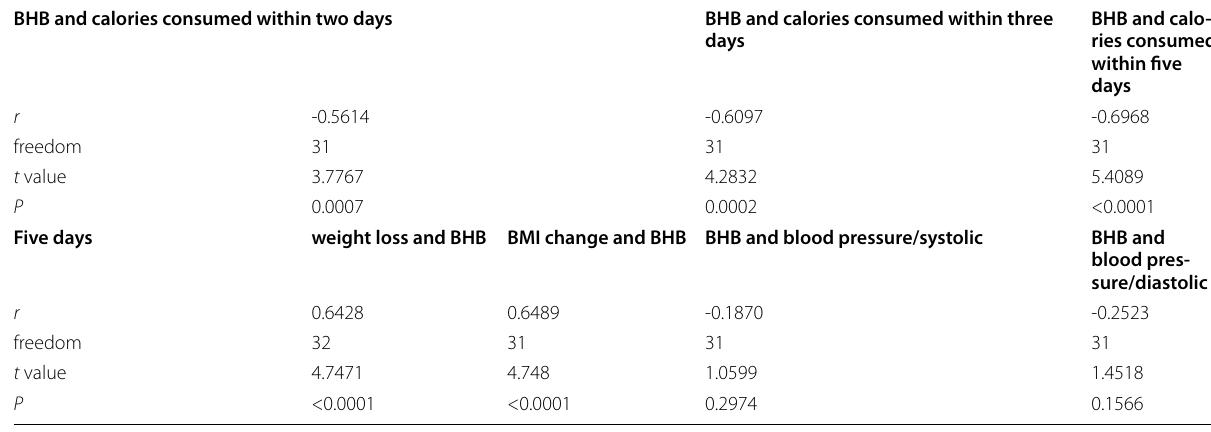
Table 3 Correlation of blood BHB level with calorie consumption, weight loss, BMI change and blood pressure BHB and calories consumed within two days BHB and calories consumed within three